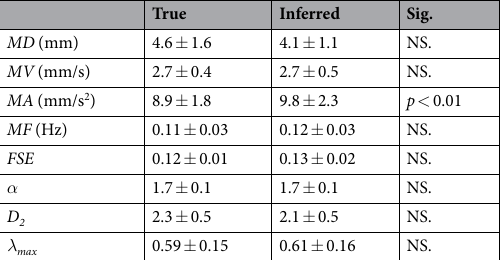
Table 1. Predictive accuracy of the inference with real subjects. Basic sway measures (Eqs (11–(14)) and nonlinear sway measures (Section Methods: Sway measures) calculated from real COMs (“True”) and the inferred COMs (“Inferred”, e.g. calculated from COM signals that were simulated with the inferred parameters). “NS.” means not significant. These results show that the real COMs and the inferred COMs are similar, except for their mean acceleration